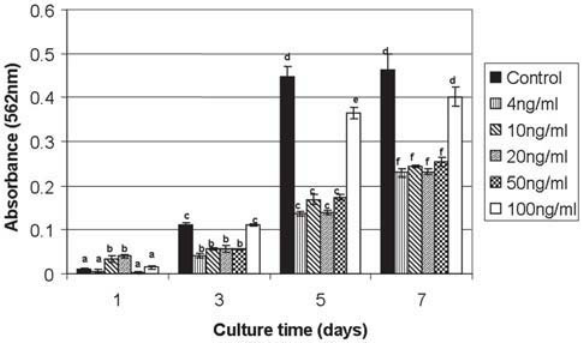
FIGURE 5- Cell viability (absorbance) of osteo-1 cells treated with five different concentrations of rhOP-1 in medium changed every 2 days after 1, 3, 5 and 7 days of culture. Data are reported as the mean ± standard deviation of one experiment performed in quadruplicate